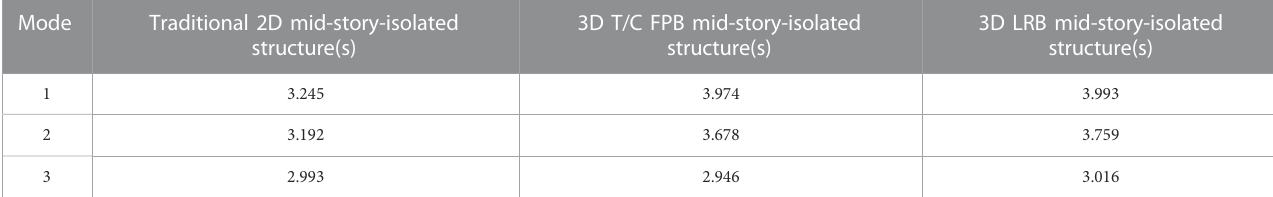
TABLE 10 First three modal periods of structures. Mode